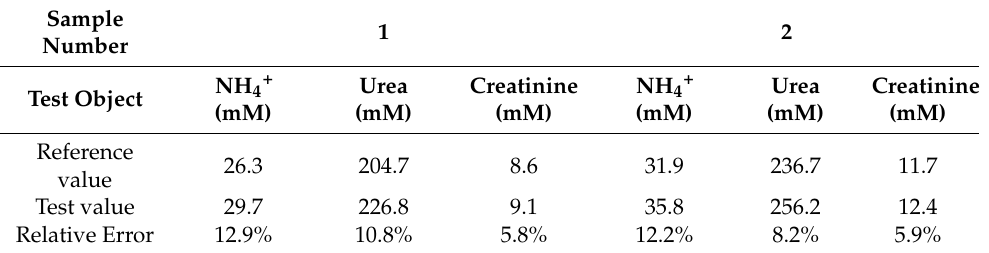
Table 4. Urine sample test results.